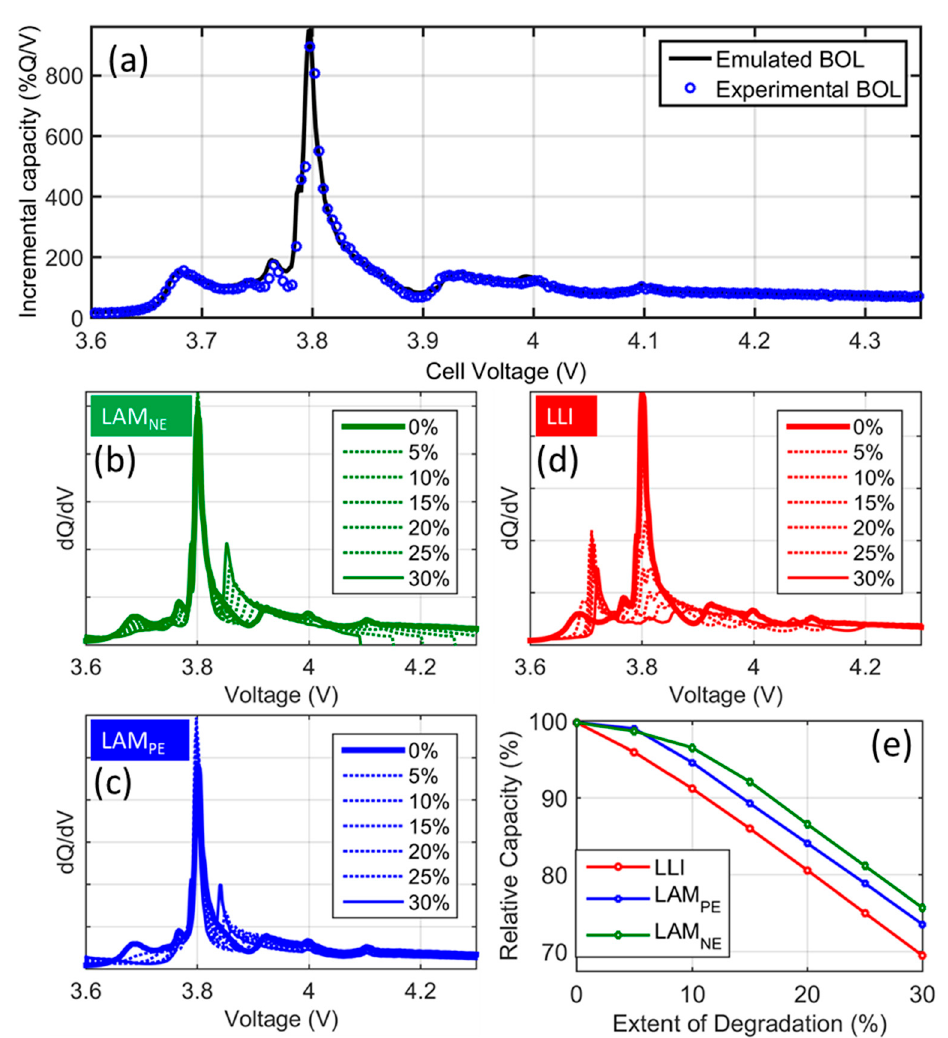
Figure 6. ( a ) Comparison of the experimental and the emulated voltage response for a C/25 charge at the beginning of life (BOL). The impact of up to 30% ( b ) LAM NE ; ( c ) LAM PE ; ( d ) LLI and ( e ) each of their associated capacity losses.